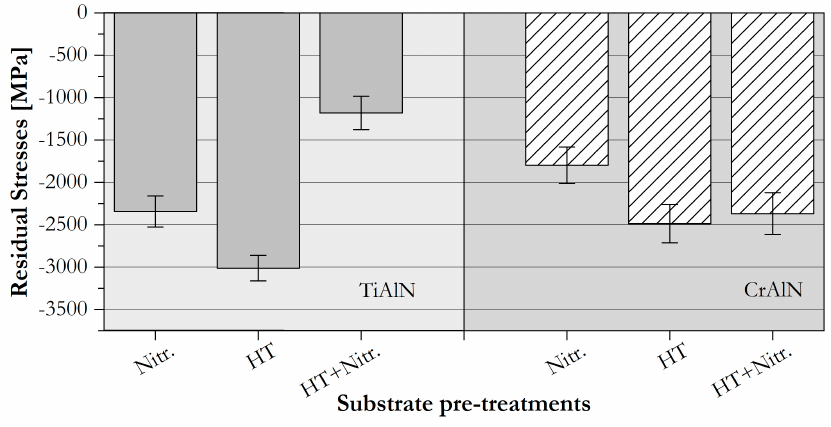
Figure 5. Residual stresses in the coatings on different substrates.